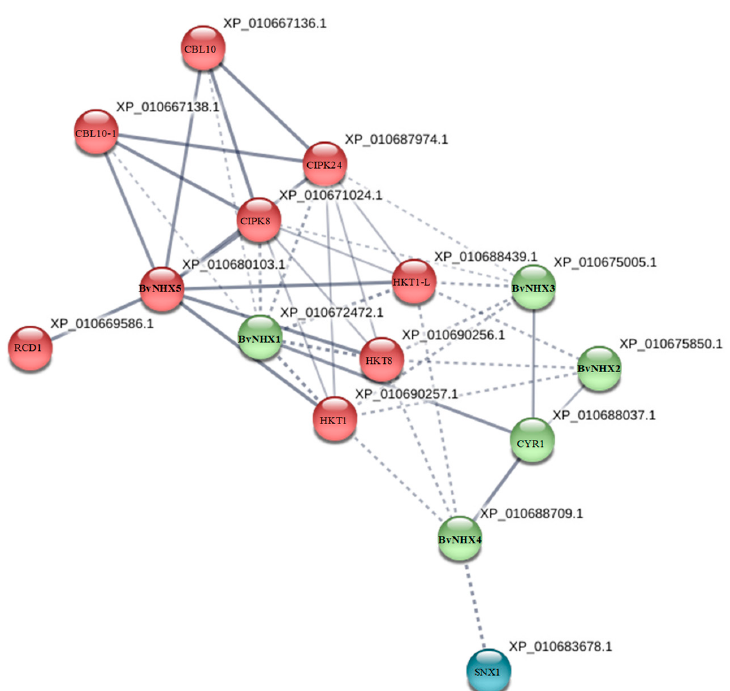
Figure 5. Protein-protein interaction (PPI) network of BvNHXs. Line thickness indicates the strength of data support. Network is clustered to 3 clusters, which are represented with red, green, and blue nodes, respectively. Details of string analysis for individual BvNHX protein are shown in Supplementary Figure S4.